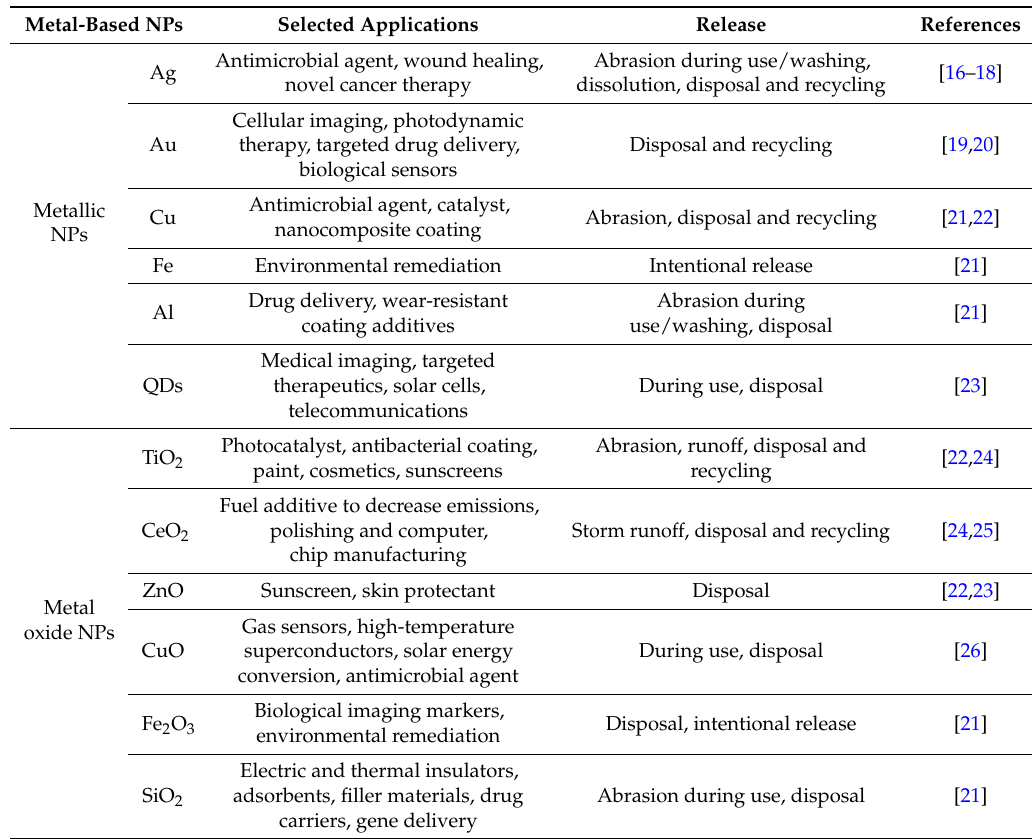
Table 1. Selected applications and intentional release of metal-based